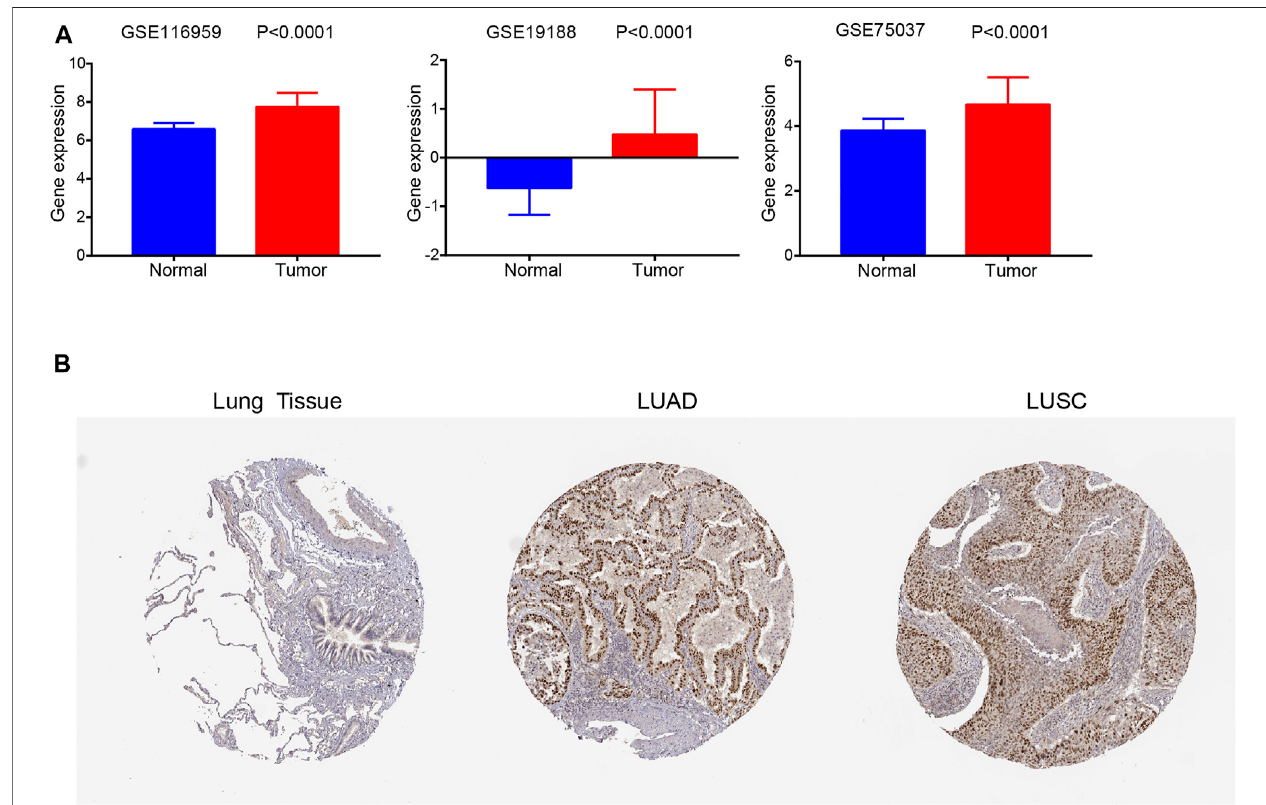
FIGURE3| FANCD2expressioninGEOdatasetsandtheHPAdatabase. (A) FANCD2 mRNAexpressionlevelswerehigherintumorsthaninnormaltissuesbased on GSE19188 and GSE116959 datasets; p < 0.01. (B) FANCD2 protein levels in LUAD and LUSC tissues and normal samples based on the HPA